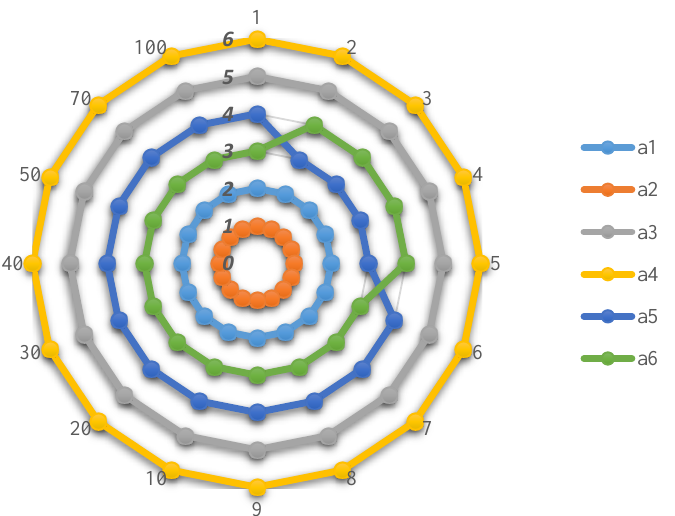
Figure 5. Ranking outcomes of different parameter 𝜆 .